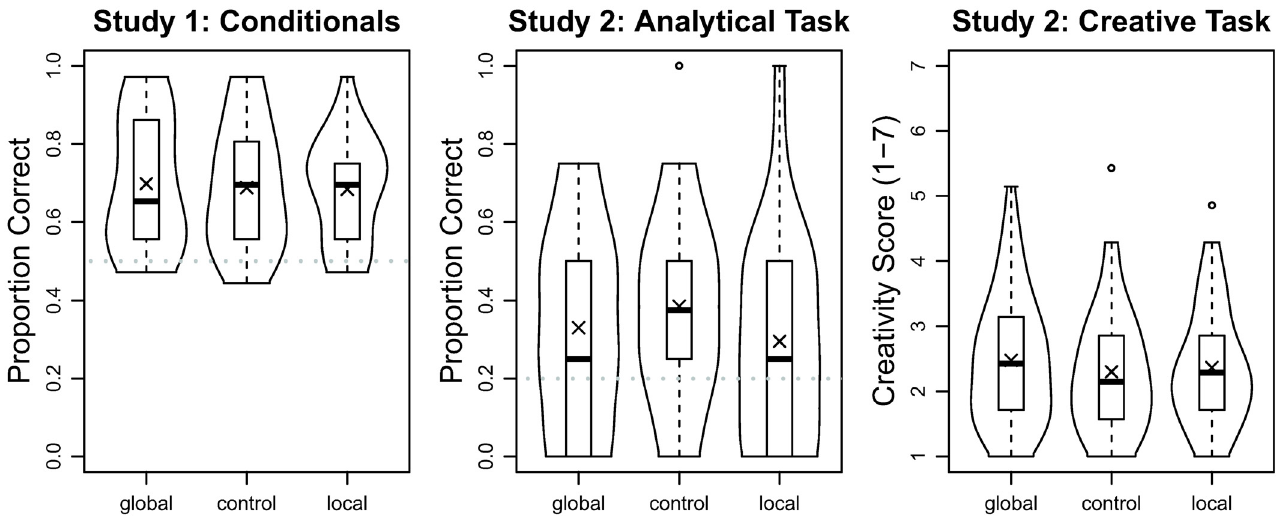
Fig 2. Violin plots of the data for Studies 1 and 2. The boxes give the interquartile range; the crosses the means; the bold horizontal lines in the boxes the medians; the dotted grey lines chance performance for the analytical tasks; overlaid to the left and the right are kernel density estimates of the distribution of the